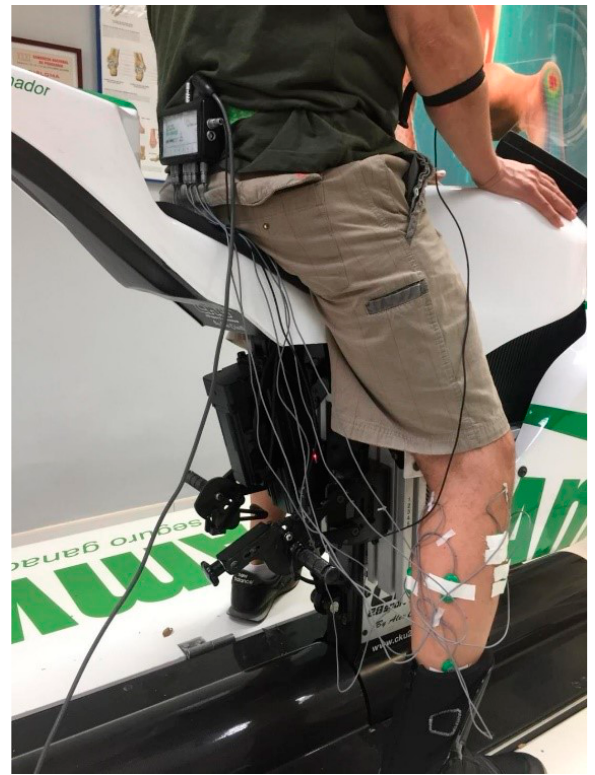
Figure 1. Right EMG electrodes positioning and their channels (E1–E7).